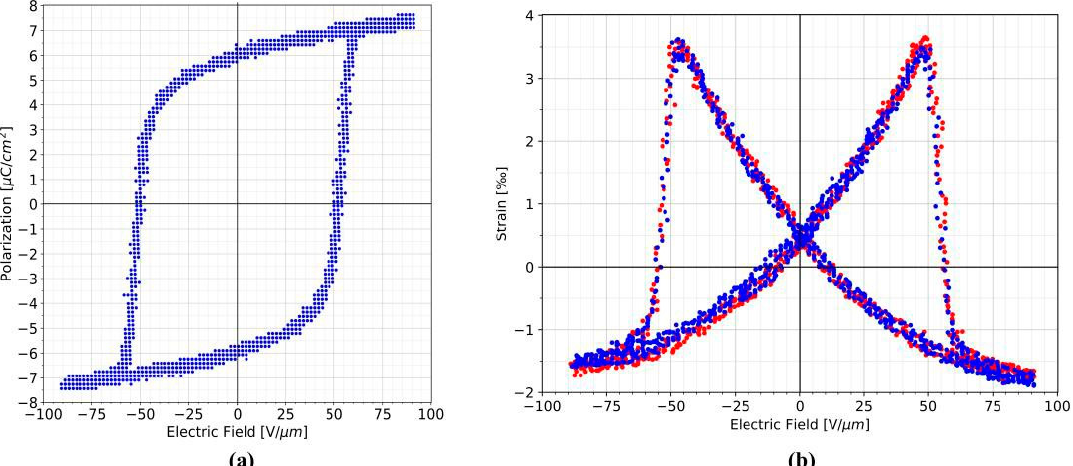
Figure 2. Ferroelectric performance of the polymer P(VDF 70 -TrFE 30 ) at room temperature and at 10 Hz: ( a ) Polarization as a function of applied electric field measured with a Sawyer-Tower bridge (P-E hysteresis, ● ); ( b ) Strain as a function of applied electric field measured with an AFM (S-E butterfly curve, ● measurement 1 , ● measurement 2